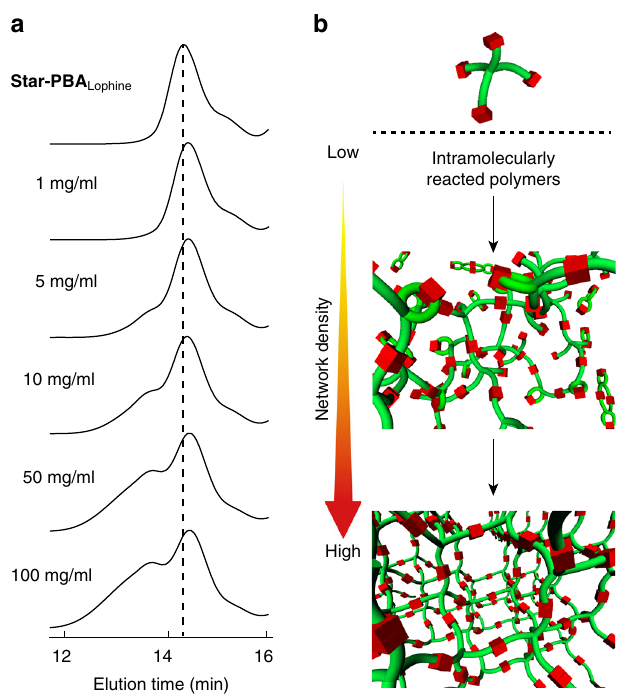
Fig. 3 Concentration-dependent repeatable MAT. a GPC traces of the products after UV irradiation to THF dispersions (1 – 100 mg/ml) of network-PBA HABI . b Schematic illustration of the dependence of the network density on